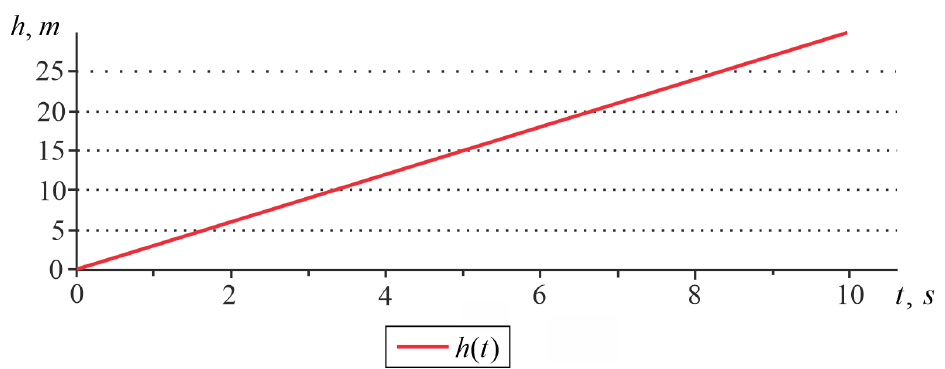
Figure 12. Estimation of height during vertical takeoff.